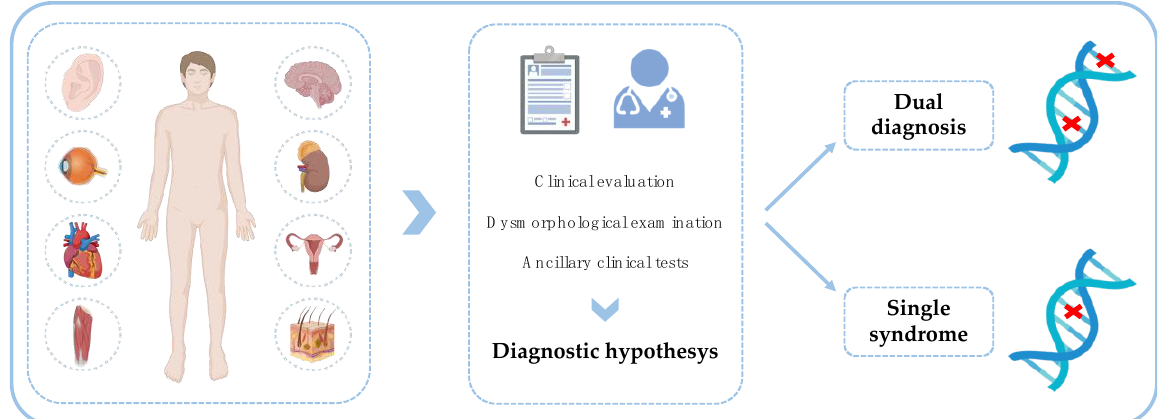
Figure 3. Diagnostic work-up of patients presenting complex clinical pictures. The first step consists in a detail clinical characterisation that is achieved through an anamnesis collection, a dysmorphological examination, and ancillary laboratory and imaging investigations. This leads to the formulation of a diagnostic hypothesis, that could immediately consider the possible presence of a dual molecular diagnosis or, on the contrary, contemplate the existence of a single syndromic condition.